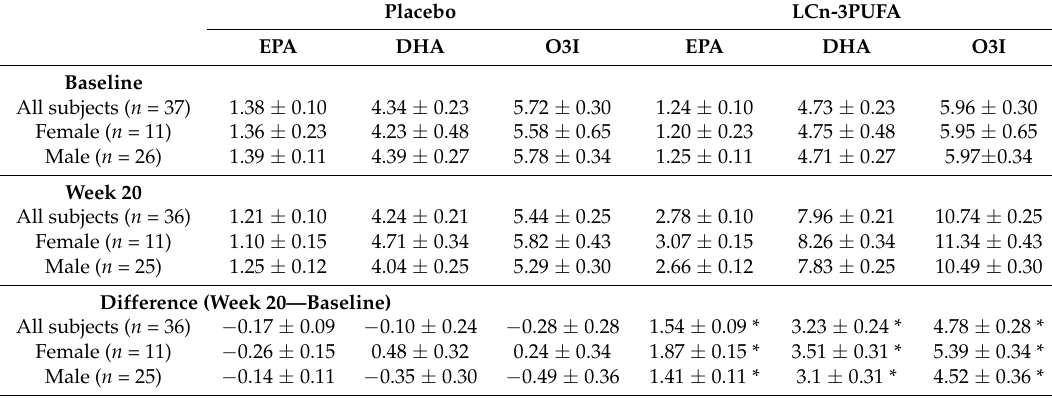
Table 5. EPA, DHA and O3I (expressed as percentages of total fatty acids) in